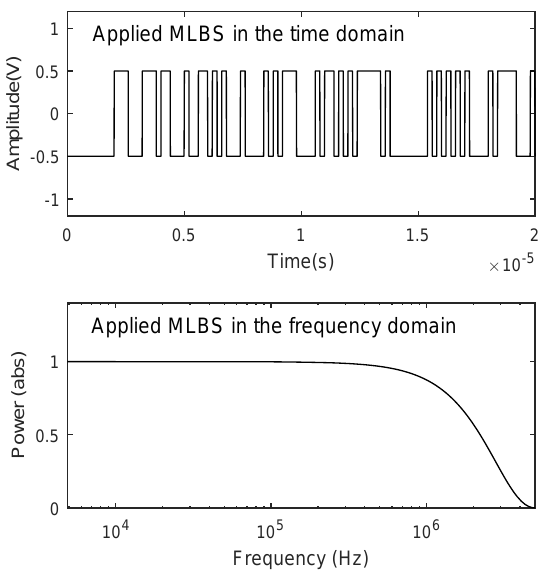
Figure 8: Sample of the applied MLBS injection in the time domain, and the spectral energy content of the